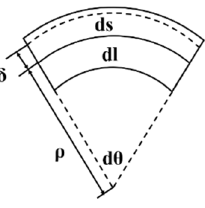
Figure 2. Side view of the bending fiber optic sensor.